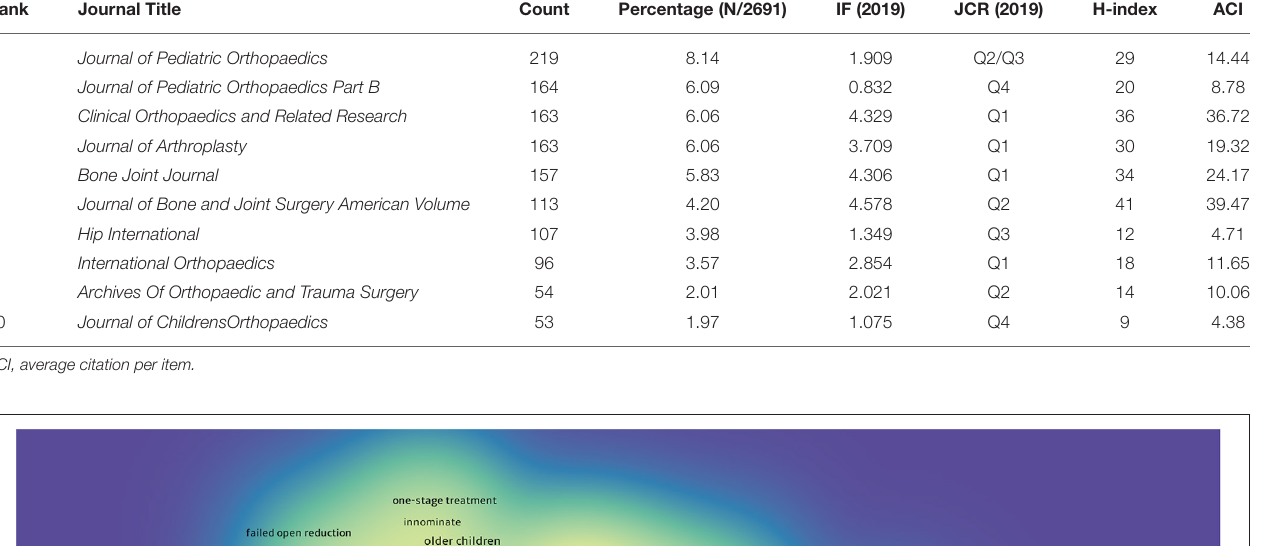
TABLE 3 | Top 10 journals in the field of DDH research ranked by the publication number.